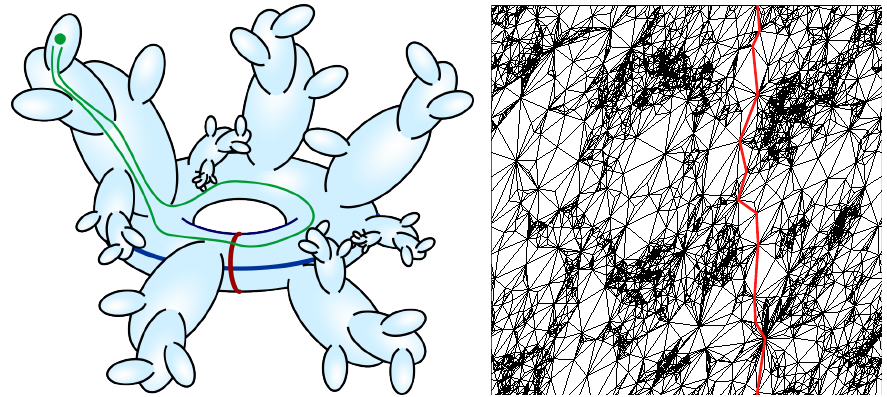
Figure 10. Left: illustration of a torus with outgrowths. The blue and red lines represent two non- equivalent and non-contractible loops. The green loop is the shortest loop passing through the green point in the same direction as the blue line. Right: embedding of a triangulation of the two-torus consisting of 150,000 triangles into the Euclidean plane (picture from [44]). Shown in red is the shortest non-contractible